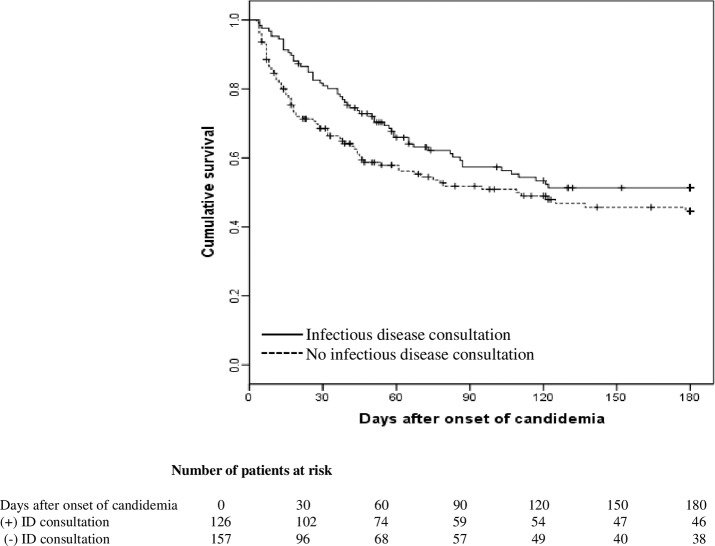
Kaplan-Meier curve of candidemia based on infectious disease consultation. Adjusted hazard ratio for 30-day mortality was 0.54 (P = 0.017), and the crude hazard ratio for 31-180-day mortality was 0.98 (P = 0.92).